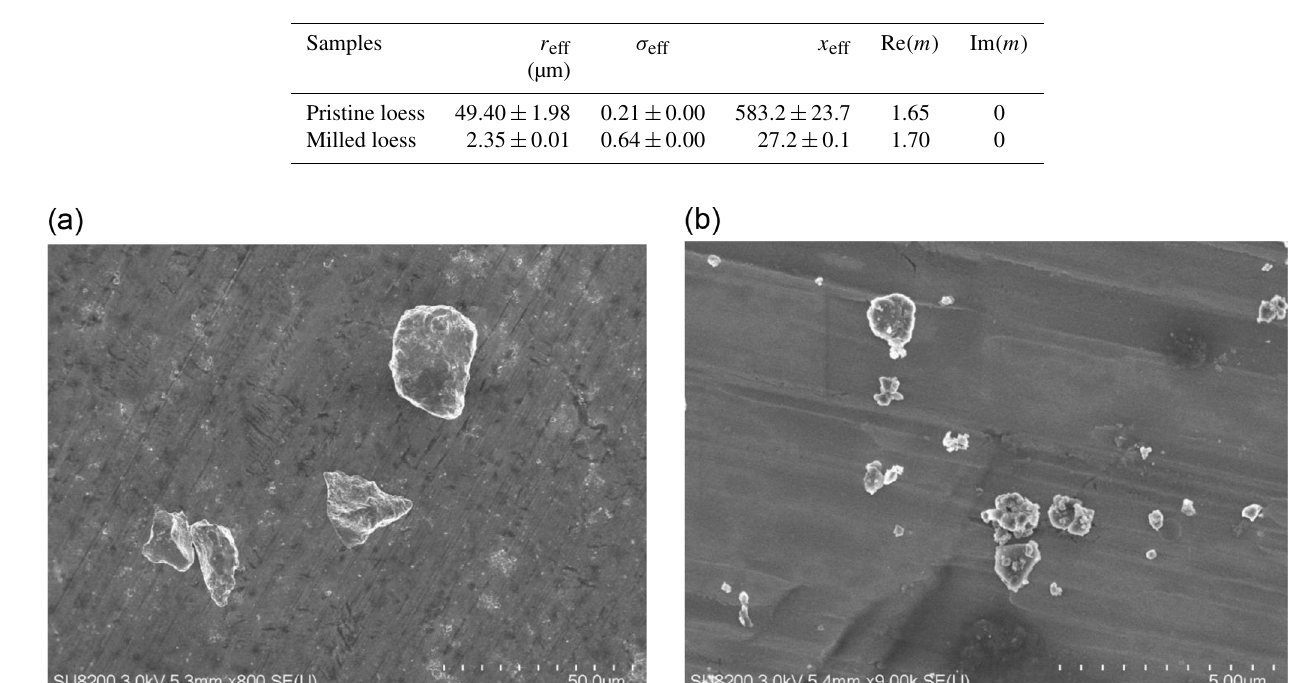
Table 1. Size parameters and refractive indices of pristine loess and milled loess.